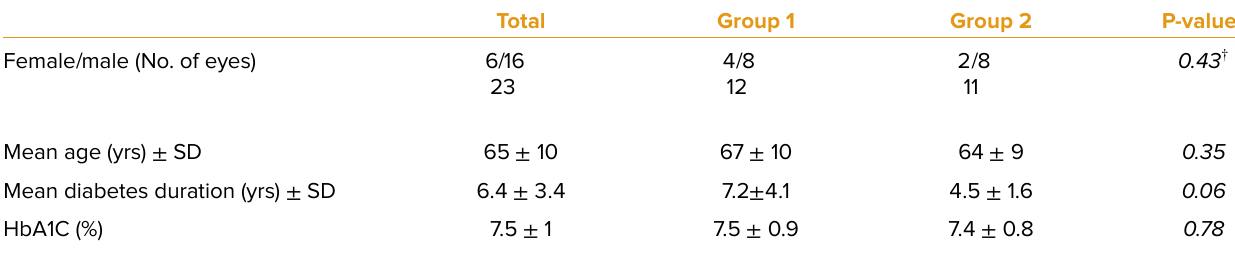
Table 1. Characteristics of patients and their systemic risk factors. Total Group 1 Group 2 P-value ∗ Female/male (No. of eyes)